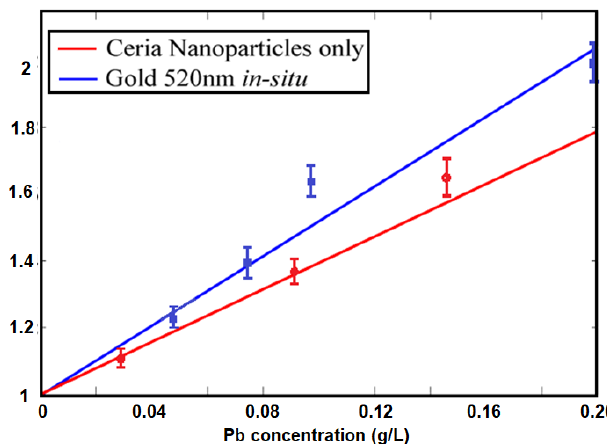
Figure 8. Stern-Volmer calculations of relative quenched fluorescence intensity at different Pb concentrations hosted by the sensing material of gold-ceria nanoparticles.